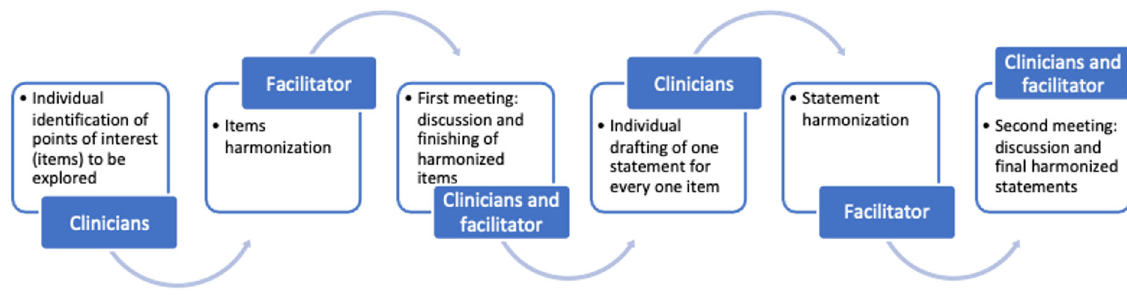
Figure 1. Project